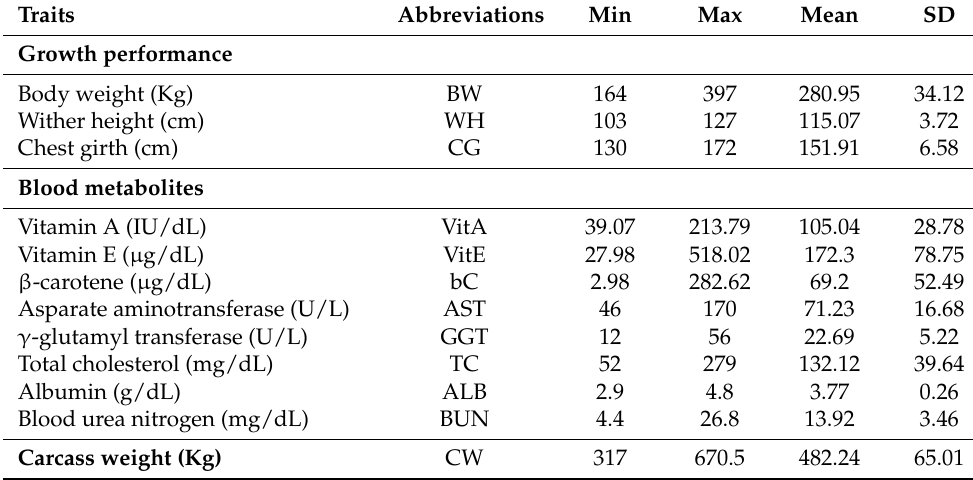
Table 1. Descriptive statistics of 675 Japanese Black cattle for growth performance, blood metabolites, and carcass weight. Growth performance and blood metabolites were measured at the start of fattening (approximately 8–10 months). SD: Standard